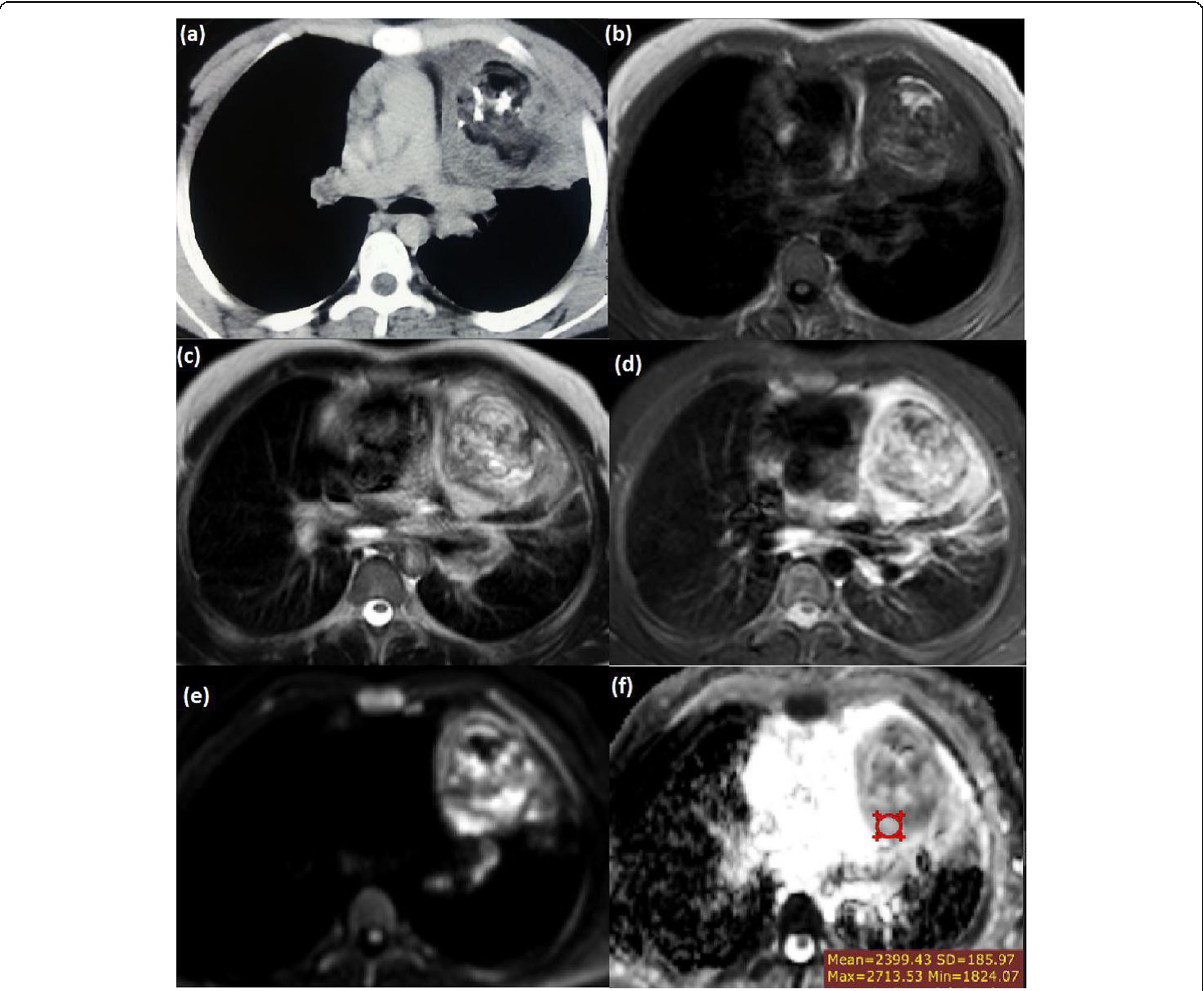
Fig. 10 Grade I immature (malignant) teratoma (pathologically proven after thoracotomy and complete excision — excised lymph nodes: free): A 13-year-old male with an anterior mediastinal (prevascular) mass identified on CT. The patient clinically presented with mild chest pain (discomfort). b Axial T1 WI, c axial T2 WI, and d axial STIR WI show a well-defined rather wedge-shaped anterior mediastinal mass displaying overall heterogeneous signal on all pulse sequences by virtue of its fat and calcific components (confirmed by referring to a axial MDCT of the chest in mediastinal window). Associated findings: Lingular collapse and small prevascular and left hilar lymph nodes, largest measures 1.5 cm. Lesion ’ s soft tissue component shows facilitated diffusion. It displays bright signal on e DWI seen corresponding to bright signal on the f ADC map: ADC mean = 2.44 × 10 − 3 mm2/s and ADC min = 1.701 × 10 − 3 mm 2